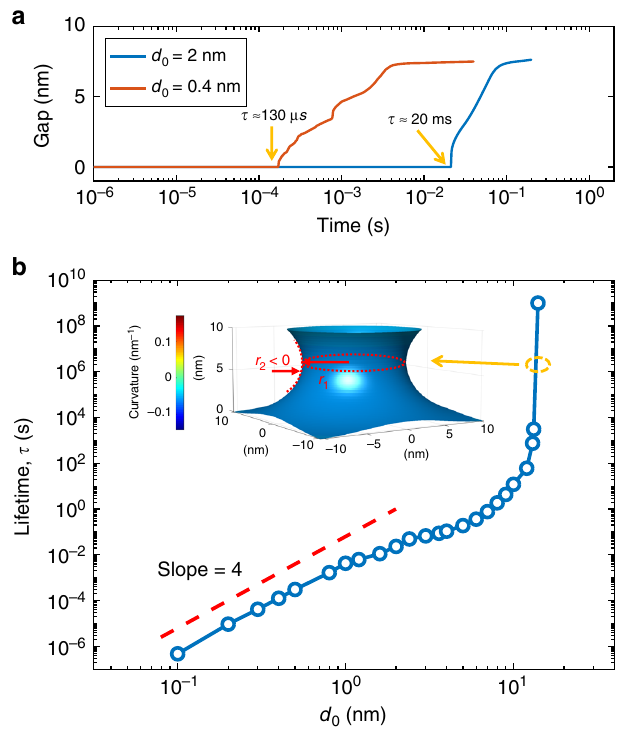
Fig. 4 CF size-lifetime scaling law. a Filament gap length as a function of the relaxation time. The increase of the gap length from zero marks the moment of CF disruption which we de fi ned as lifetime τ . b Filament disruption time as a function of initial fi lament diameter d 0 . The size-time scaling for thin fi lament ( d 0 ≪ 10 nm, h = 10 nm) well agrees with Herring ’ s law τ (cid:3) d 4 with a slope of 4, while, on the other hand, for thick fi lament ( d 0 0 > 10 nm), the lifetime more rapidly increases with the lateral size as a stable capillary bridge is formed, marking an increase of the lifetime from microseconds to years with increasing fi lament diameter. Inset: snapshot of a stable capillary bridge formed from fi lament with initial diameter d 0 = 14 nm. The stability of this shape originates from the two principle radii of surface curvature having equal modulus and opposite signs. In the bottleneck point, the horizontal radius of the surface curve r 1 > 0, whereas the vertical radius r 2 < 0, resulting in the surface curvature κ tending to zero